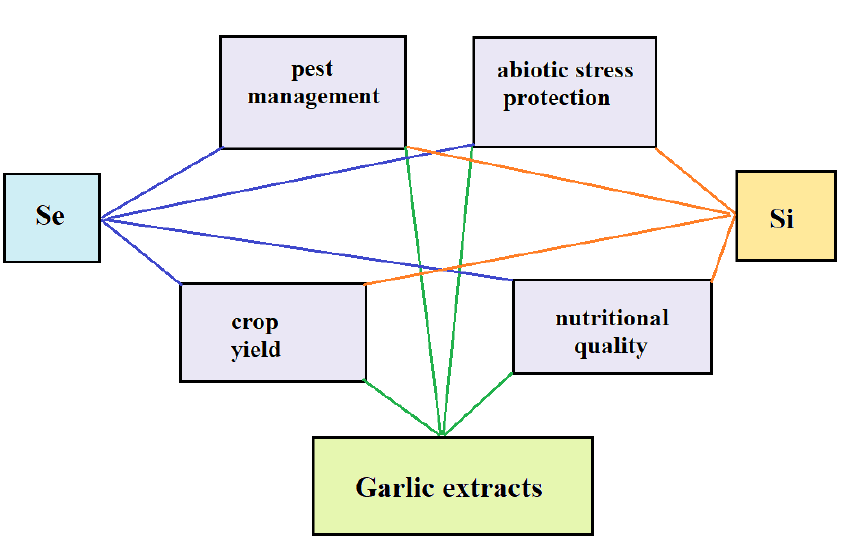
Figure 6. Beneficial effects of Se and Si compounds, and garlic extracts’ utilization.